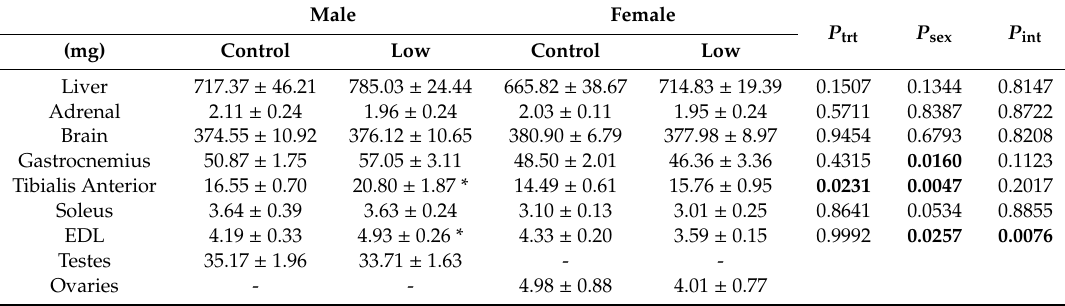
Data are mean ± SEM with all weights in milligrams. All weights are litter averages for each sex. All measurements of adrenals, gastrocnemius, tibialis anterior, soleus, EDL (extensor digitorum longus), testes and ovaries include the total weight from both the left and right side of the body. Data analysed by two-way ANOVA with treatment ( P trt ) and sex ( P sex ) as major factors. P int represents an interaction between treatment and sex. When a major e ff ect was detected, a Sidak posthoc test was performed. Bold text indicates that a major e ff ect reached significance. * = p < 0.05 indicated posthoc analysis compared to control of same sex. Unpaired t -test was conducted on reproductive organs. n = 6–9 litters.